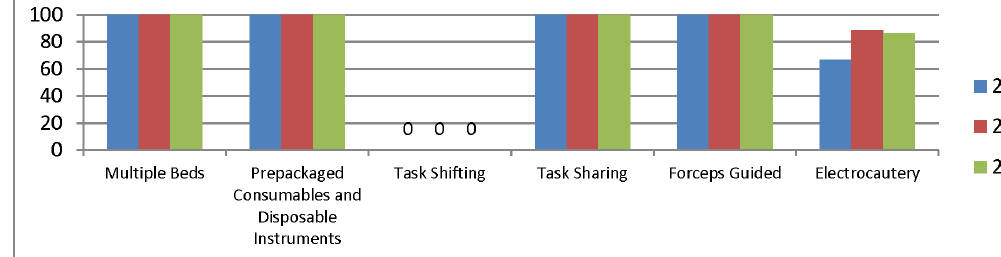
Figure 6. Proportion of sites adopting each efficiency element by year and by country.